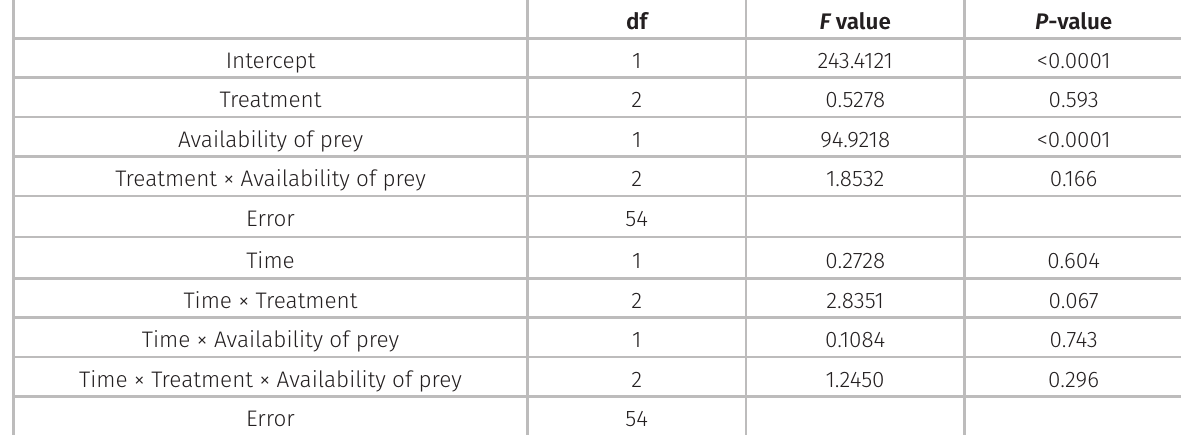
Table I. Results of two-way repeated-measures ANOVA of larval mortality of Cycloneda sanguinea and Eriopis connexa on sweet-pepper plants for different forms of predation (conspecific and heterospecific) with or without an extraguild